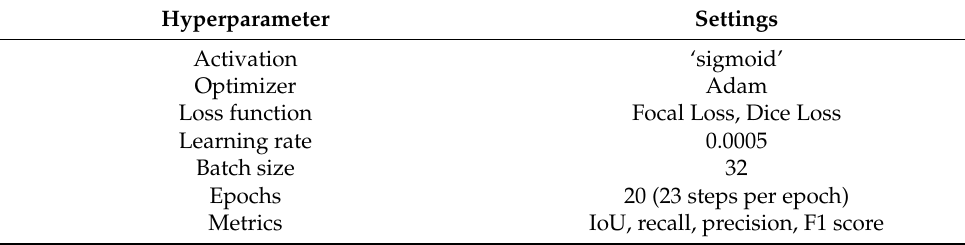
Table 2. Models’ hyperparameter